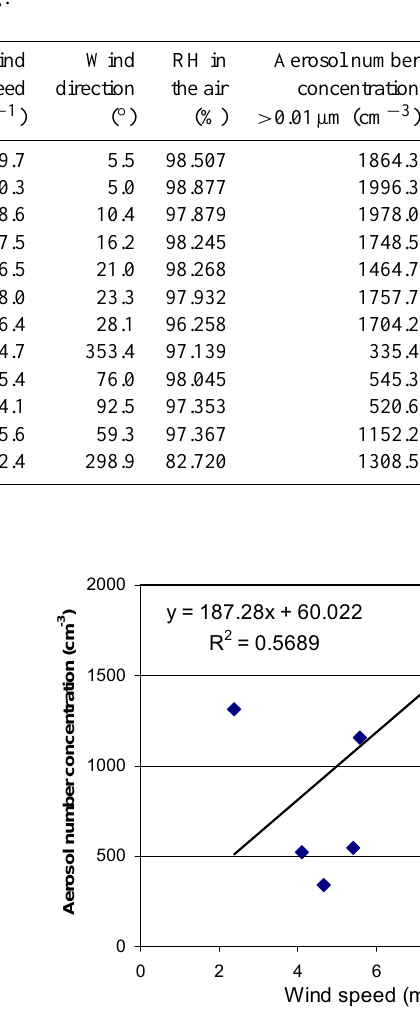
Fig. 7a: Concentration of freezing nuclei at -23ºC as a function of wind speed. Fig. 7a. Concentration of freezing nuclei at − 23 ◦ C as a function of wind speed.